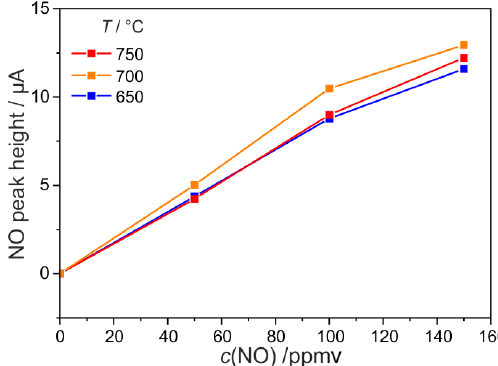
Figure 10. SWV at T = 750 ◦ C and different NO concentrations; other experimental conditions as declared in Fig. 9.